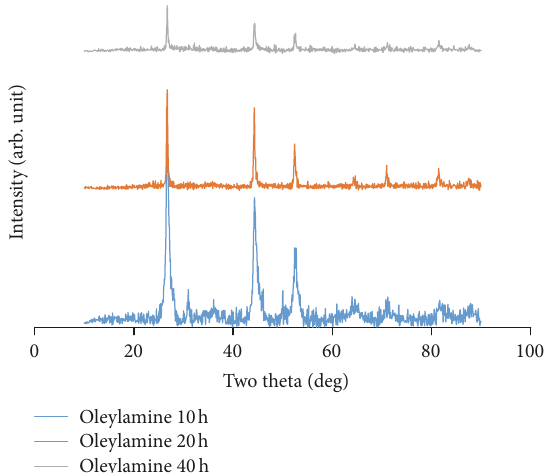
Figure 1: XRD pattern of synthesized CIS powder at 240 ∘ C for 10, 20, and 40 hours with oleylamine solvent.